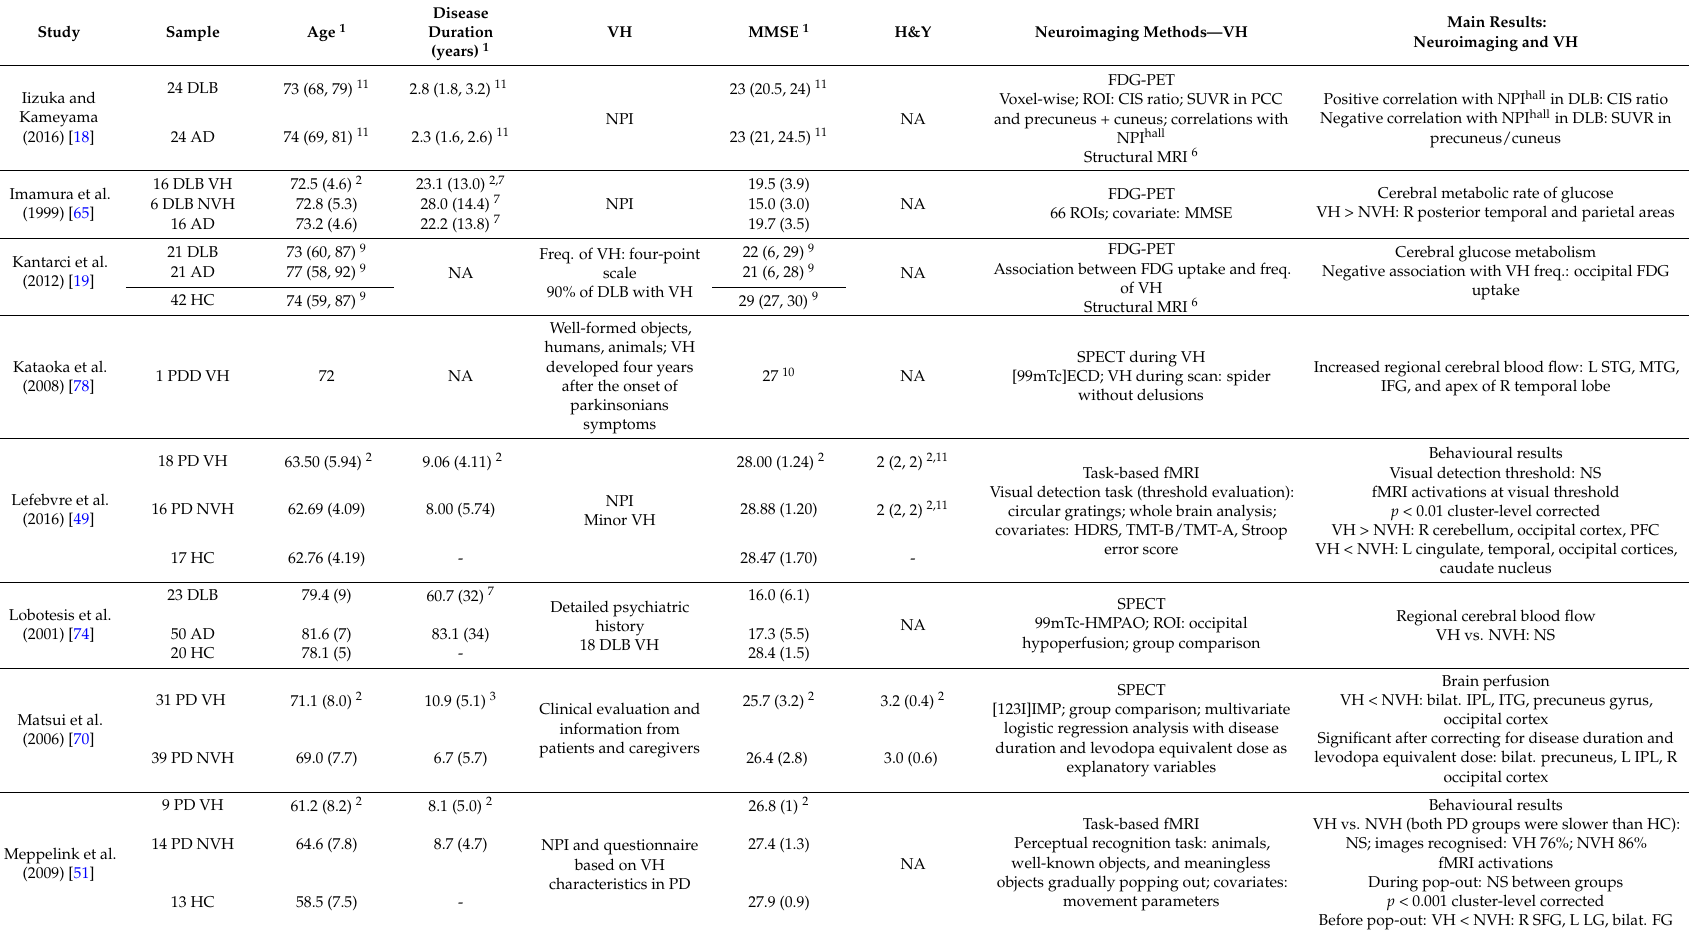
Main Results: Neuroimaging and VH